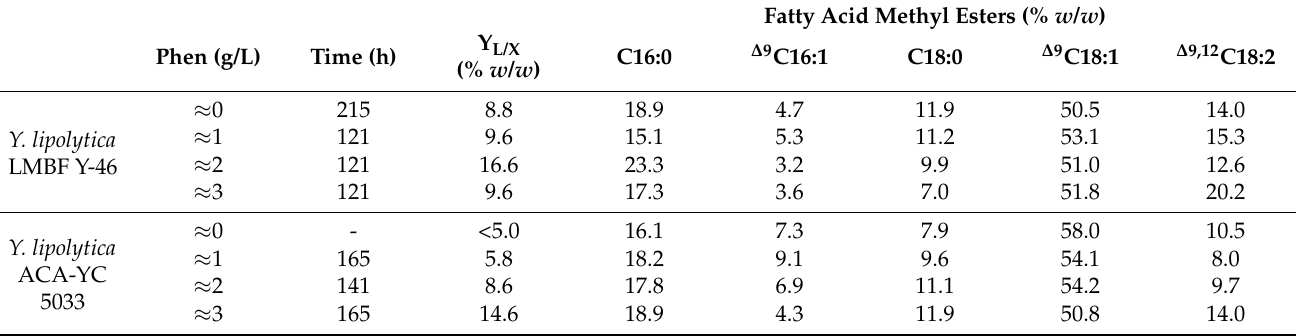
Table 2. Intercellular lipid accumulation (Y L/X, % w / w ) and the fatty acid composition of lipids (%, w / w , when the maximum lipids were produced in terms of both absolute and relative values) produced by Y. lipolytica LMBF Y-46 and ACA-YC 5033 on blends of olive mill wastewater (OMW) and crude glycerol under nitrogen-limited conditions in shake-flask fermentations. The blends of OMW-glycerol were properly formulated to have different initial phenolics concentrations (Phen) of ca. 1 g/L, 2 g/L and 3 g/L. Fatty Acid Methyl Esters (% w / w